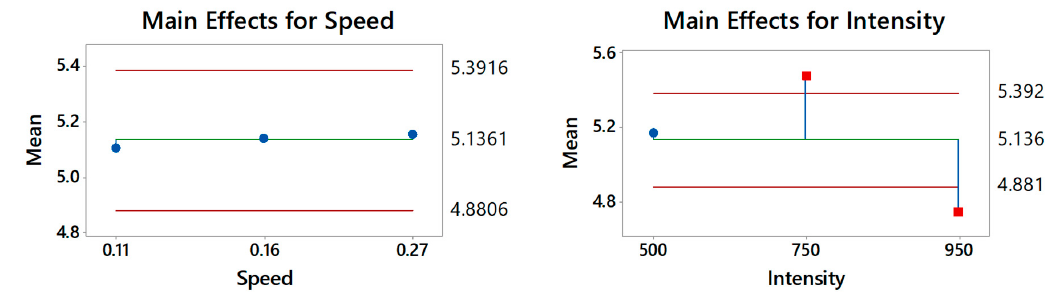
Figure 13. ANOM for the Fixed scan setup.